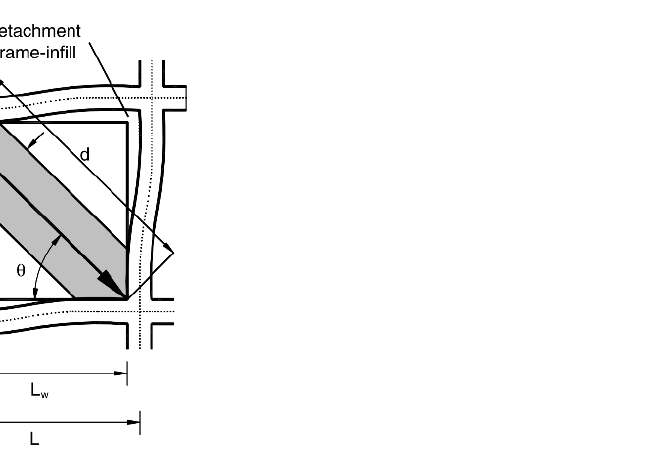
Figure 3. Equivalent diagonal strut model for an infill masonry wall in a RC frame, with other concepts of deformation, detachment, and width. Table 7. Effective width for the equivalent infill strut proposed by different authors.